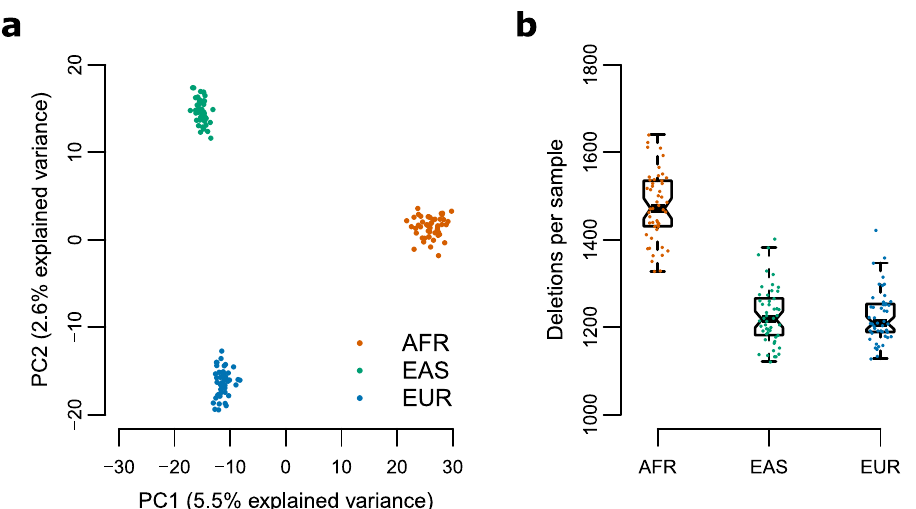
Fig. 4 Analysis of PopDel ’ s deletion calls on the Polaris Diversity cohort. The Polaris Diversity cohort consists of 50 individuals from three continental groups each. a Principal component analysis. b Number of deletions per genome. Africans carry signi fi cantly ( P value <2.2 × 10 − 16 , two-sided t test) more deletions than Europeans and East Asians. Each point represents an individual. Center line denotes median. Boxes limit upper and lower quartiles. 1.5x interquartile ranges are given as whiskers. AFR, African; EAS, East Asian; EUR,